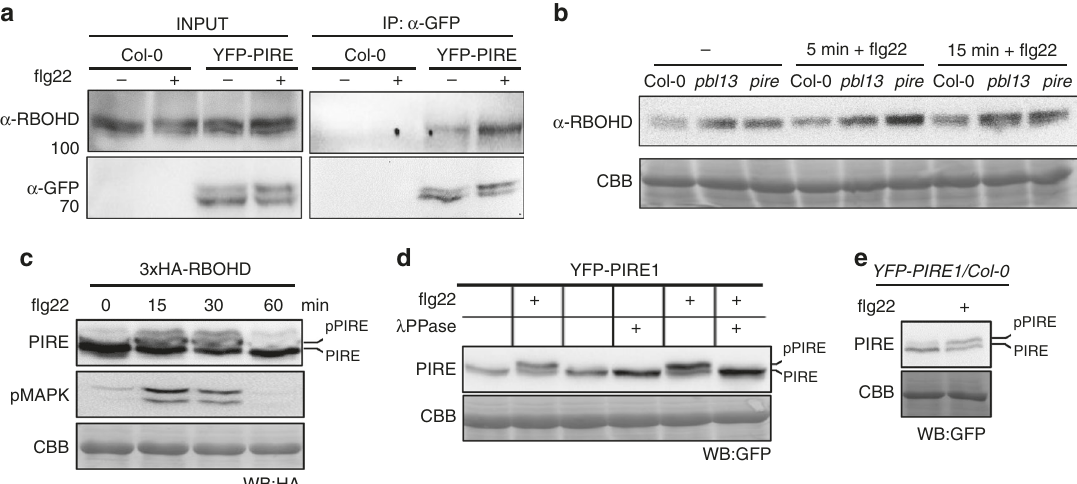
Fig. 6 PIRE constitutively associates with RBOHD but is dynamically phosphorylated after immune activation. a PIRE associates with RBOHD after immune activation. YFP-PIRE-expressing Arabidopsis seedlings were treated with fl g22 for 15 min. Microsomal fractions were isolated and subjected to co- immunoprecipitation using anti-GFP antibodies. b RBOHD expression is enhanced in pbl13 and pire knockout lines at a resting state. RBOHD expression was detected by immunoblotting with anti-RBOHD after fl g22 treatment. c PIRE mobility shift is detected upon PAMP perception. 3xHA-PIRE was expressed in N. benthamiana followed by fl g22 treatment. Immune activation by fl g22 was con fi rmed by anti-pMAPK immunoblotting. d PIRE is phosphorylated in vivo. 3xHA-PIRE phosphorylation was induced by fl g22 treatment in N. benthamiana . PIRE ’ s phosphorylation is inhibited by lambda phosphatase ( λ PPase) treatment. e PIRE is phosphorylated in an Arabidopsis transgenic line expressing YFP-PIRE after fl g22